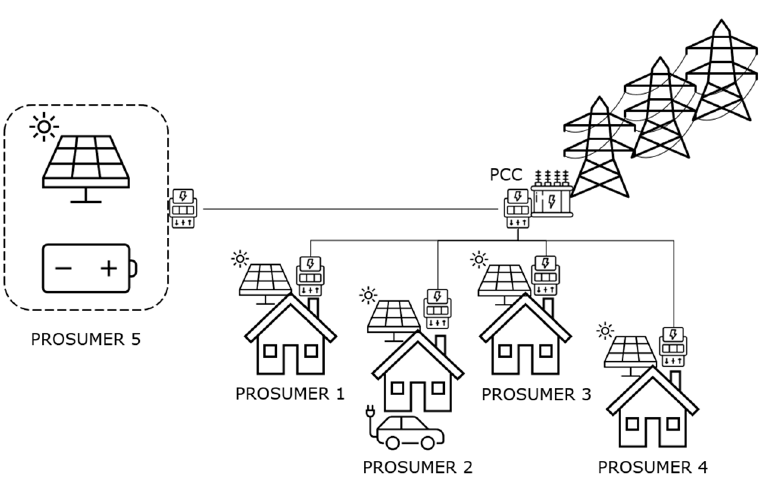
Figure 2. LEC organised as Community of Prosumers.